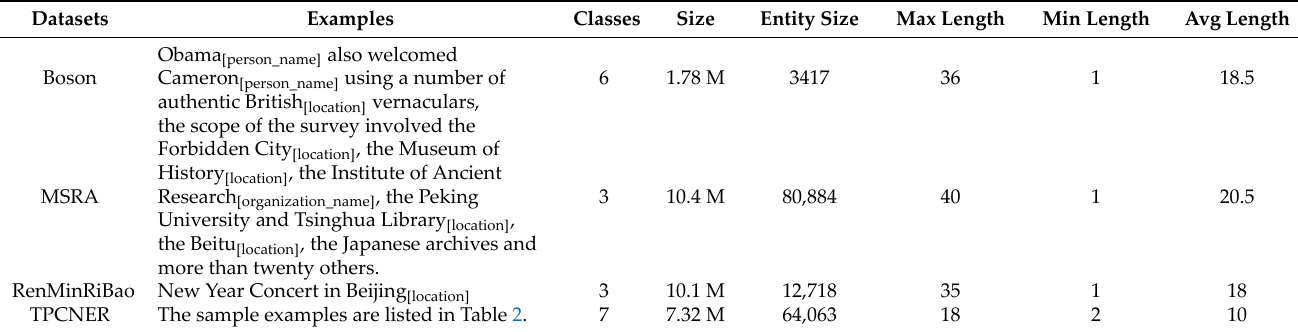
Table 6. Comparative information between TPCNER and other